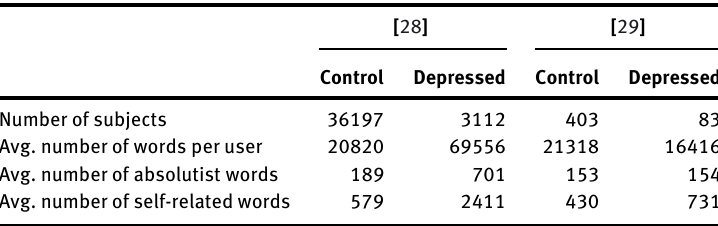
Table 2: Statistics of the training datasets.